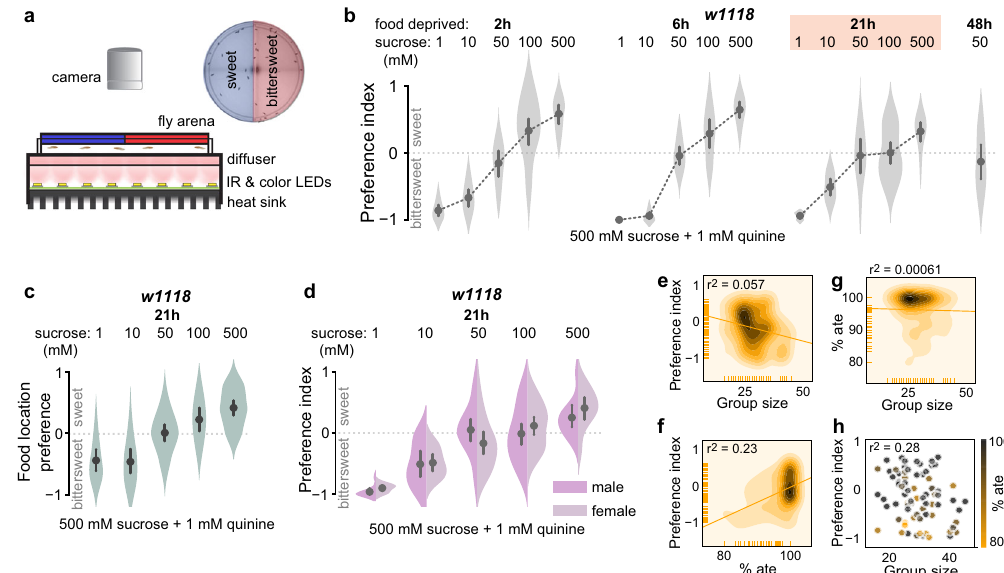
sory information . We quanti fi ed the choices of wild-type fl ies deprived of food for different durations between a range of increasing concentration of sweet (sucrose-only) food option and a constant bittersweet (sucrose + quinine) option, with each option including either a red or blue food dye (Fig. 1a). Food choice was quanti fi ed by scoring the color of the food in each fl y ’ s abdomen at the end of the assay. A preference index was then